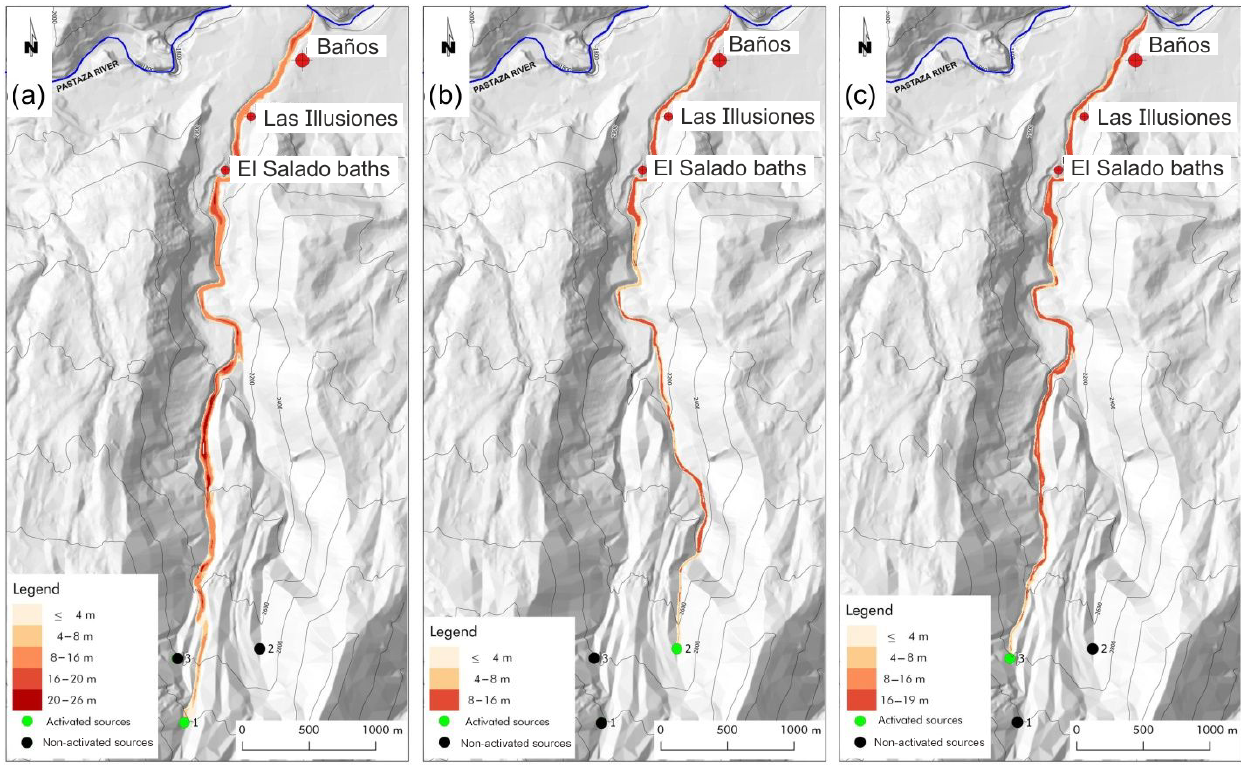
Figure 10. Single triggering events: lahar generated in point 1 (a) , in point 2 (b) , and in point 3 (c) . The legend specifies the maximum thickness of the lahar reached during the conjectured events for each point